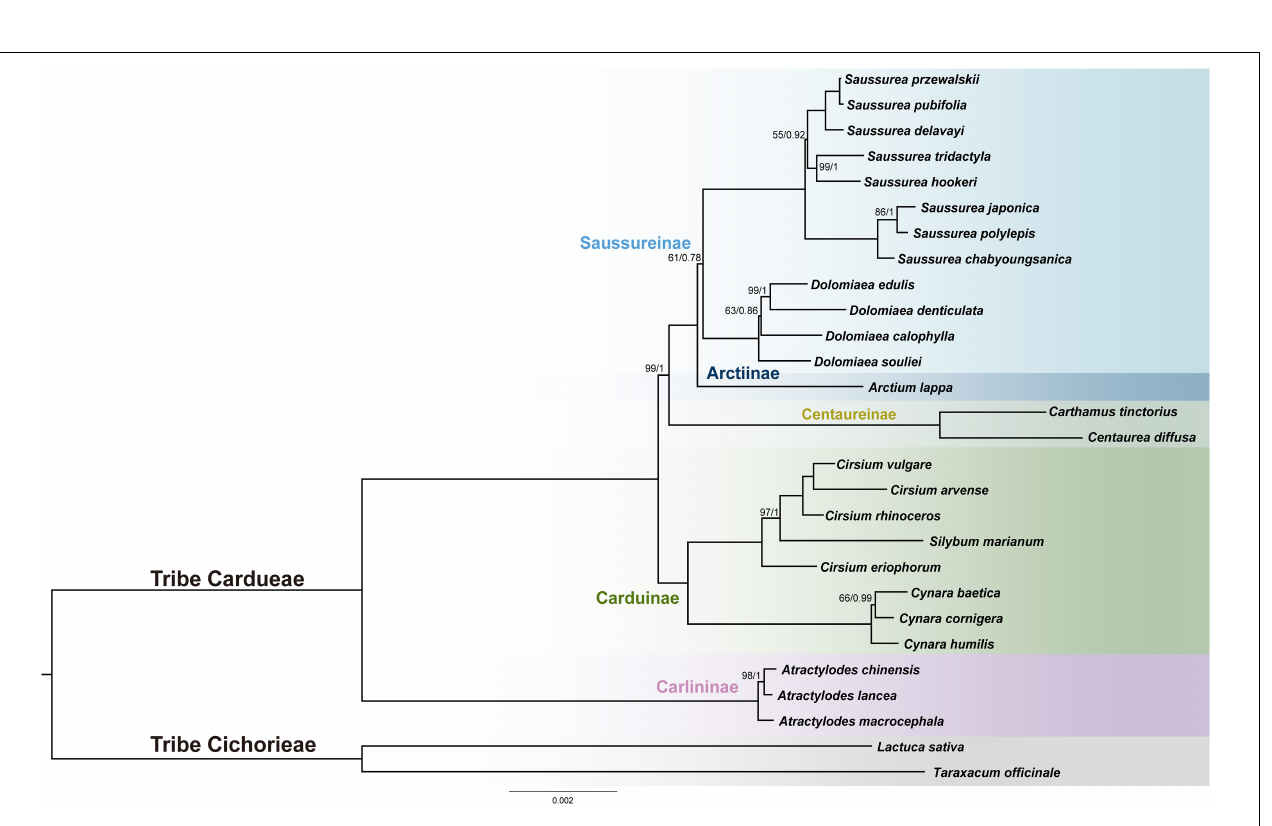
FIGURE 6 | Phylogenetic reconstruction of Cardueae from maximum likelihood (ML) and Bayesian inference (BI) analyses using concatenated 79 protein-coding regions. The ML tree is shown. Maximum likelihood bootstrap values (BS) and posterior probabilities (PP) are shown at nodes. Branches with no values listed have 100% BS and PP of